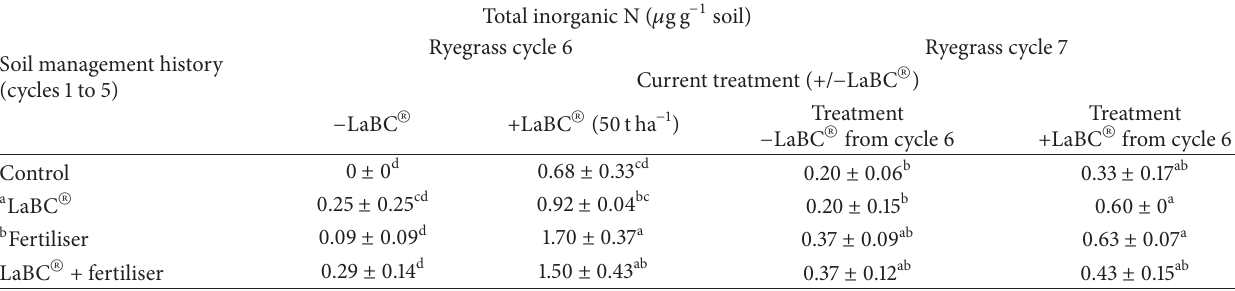
Table 8: Total inorganic N ( 𝜇 gg −1 soil) in ryegrass cycles 6 and 7 with reapplied LaBC Ⓡ (+/ − ) as influenced by residual effects of soil amendments from previous management history.